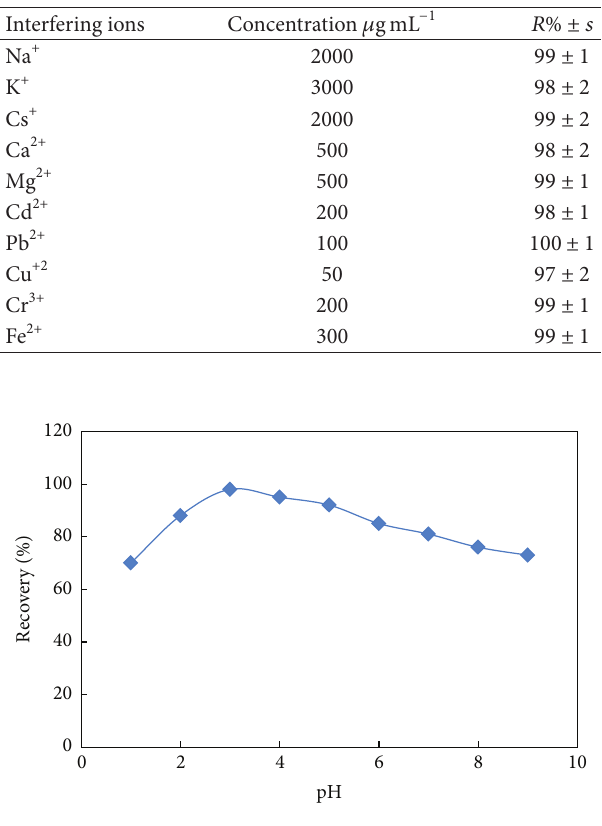
rates higher than 9 mL min